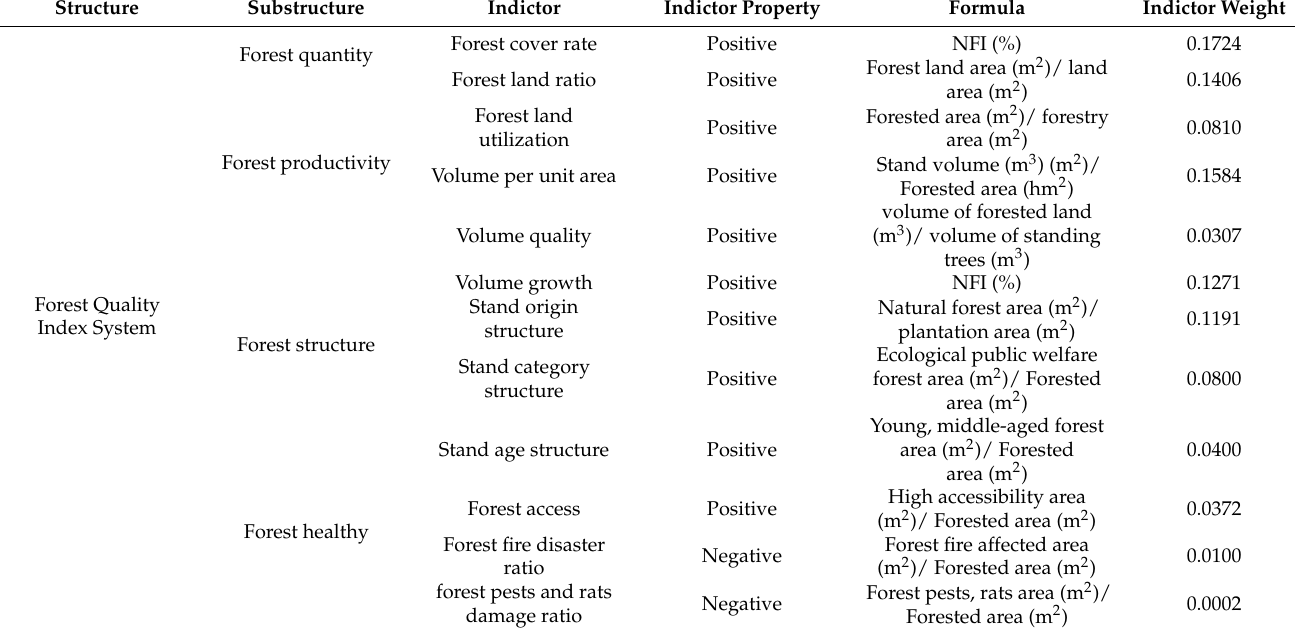
Table 3. Forest quality index system and its